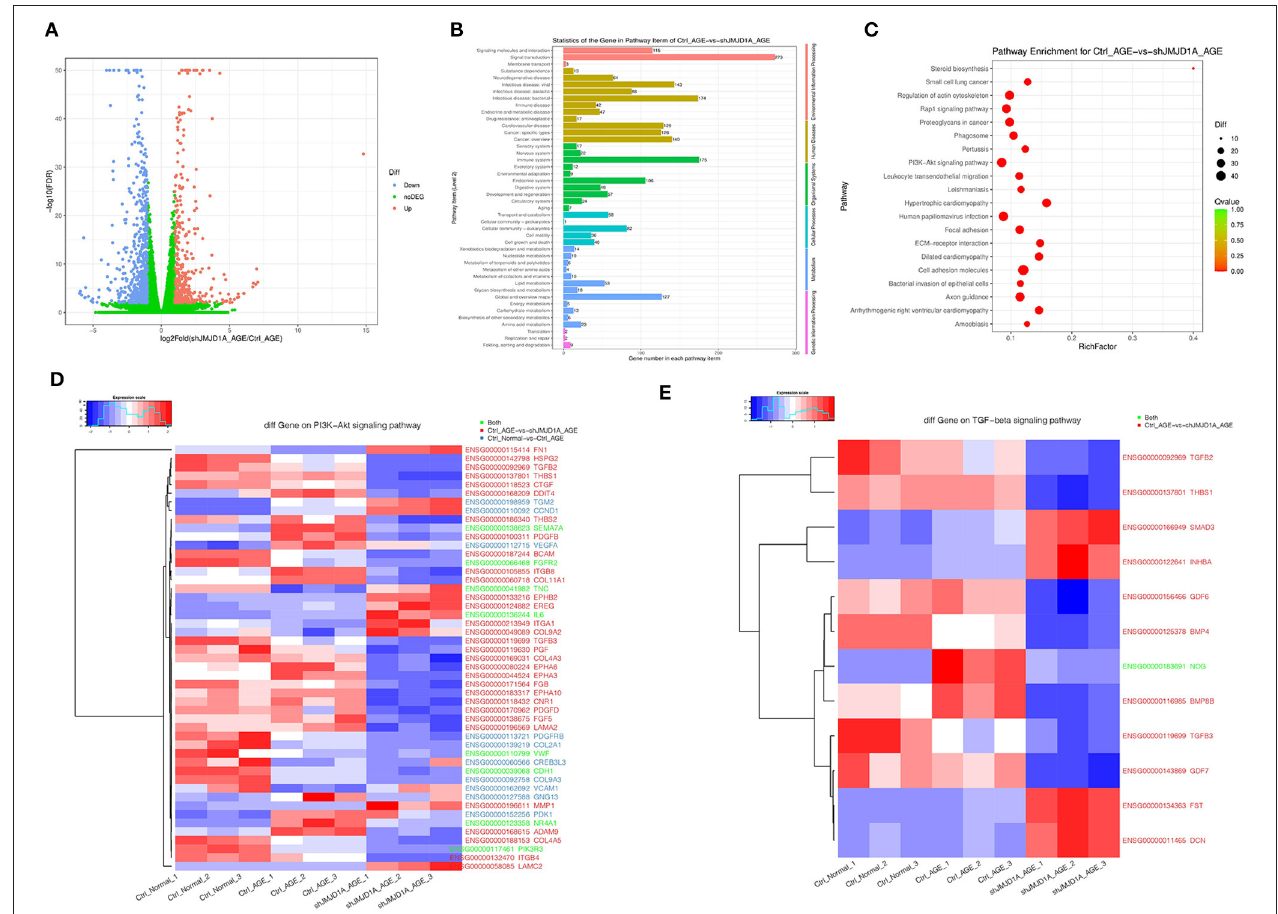
FIGURE 7 | Gene expression and heatmaps of HK-2 cultured with 400 µ g/ml AGEs for 72h by RNA-seq. (A) Volcano plot was used to show the difference in gene expression values between the Ctrl_AGEs group and the shJMJD1A_AGEs group. Green dotted line indicates the threshold for p < 0.05 and log FC < 2. Blue and red points represent downregulated and upregulated DEGs, respectively. (B,C) GO and KEGG enrichment analysis of differentially expressed genes (correct p < 0.05). Red bubbles show KEGG pathways. (D,E) Heatmaps of differentially expressed genes related to the PI3K-Akt and TGF- β signaling